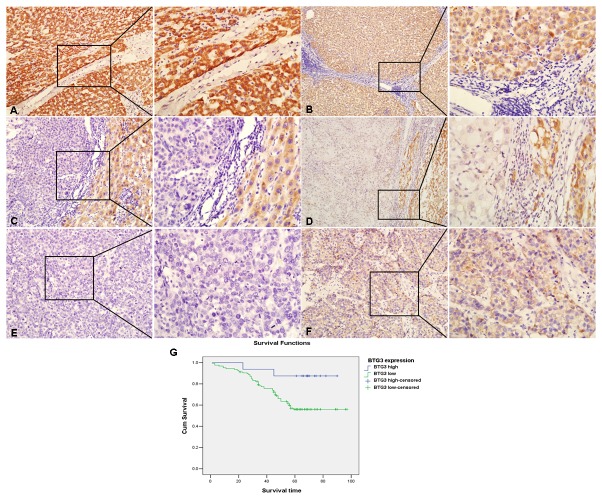
BTG3 is down-regulated in clinical paraffin-embedded HCC tissues and a prognostic factor for poor overall survival in HCC patients.(A) Strong positive expression of BTG3 in adjacent normal livers (×200, ×400). (B) Positive expression of BTG3 in the cirrhotic livers (×100, ×400). (C) Negative expression of BTG3 in HCC tissues compared with strong positive expression in adjacent livers (×200, ×400). (D) Week expression of BTG3 in HCC tissues while strong positive expression in adjacent livers (×200, ×400). (E) Negative expression of BTG3 in HCC tissues with low differentiation (×200, ×400). (F) Weak expression of BTG3 in HCC tissues with high differentiation (×200, ×400). (G) Kaplan-Meier survival analysis of primary HCC patients with high and low BTG3 expressions.